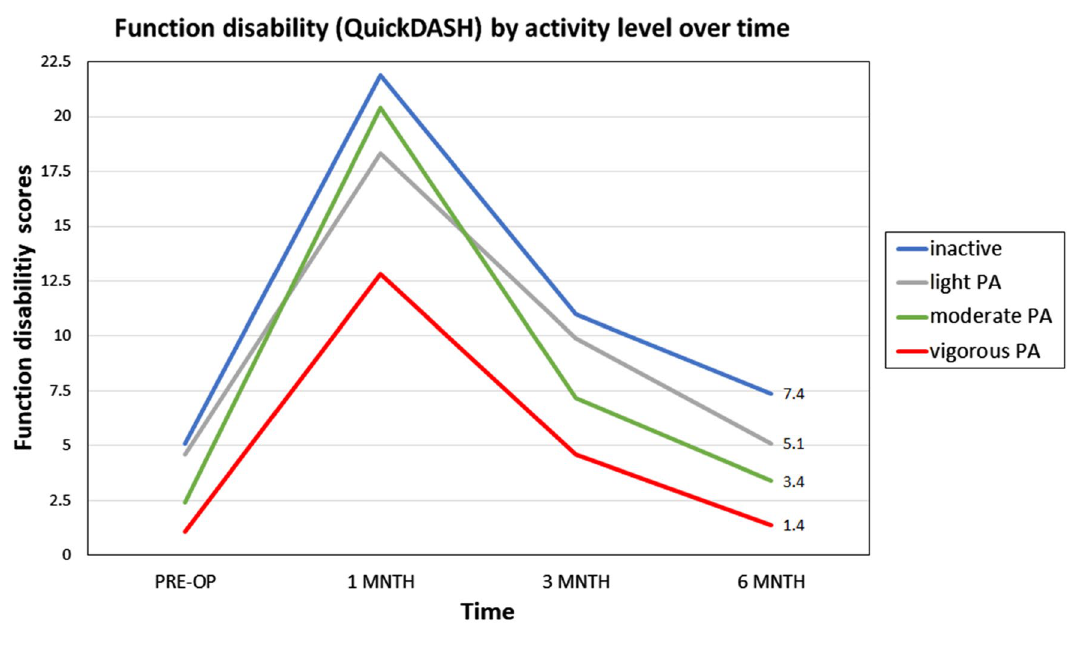
Figure 2. The effect of physical activity on function disability scores by activity level over time.